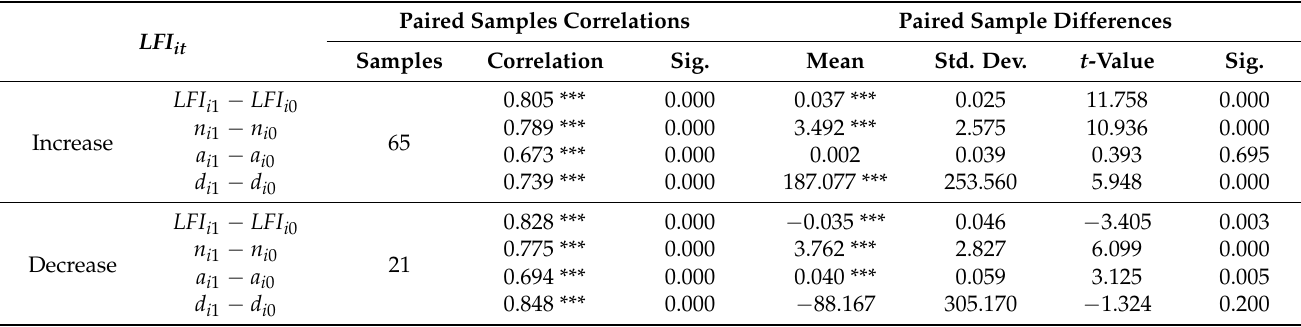
Table 6. Results of paired sample t-test for change of LF degree in scenario 1.